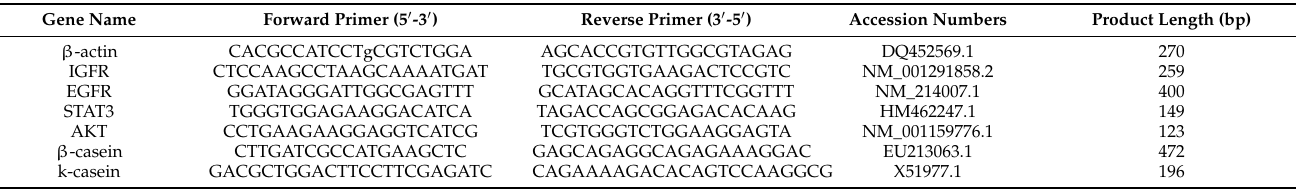
Table 1. Primers of genes used for